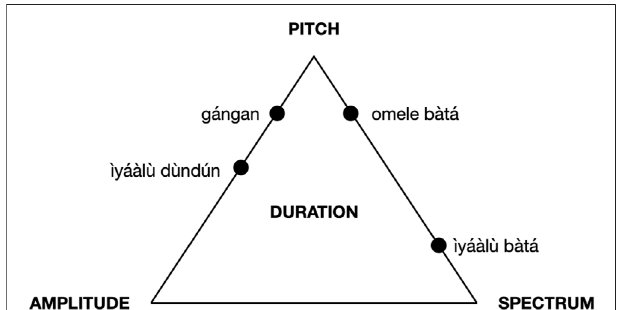
FIGURE 11 | Placement of the studied drums according to their addressing of pitch, amplitude, duration and